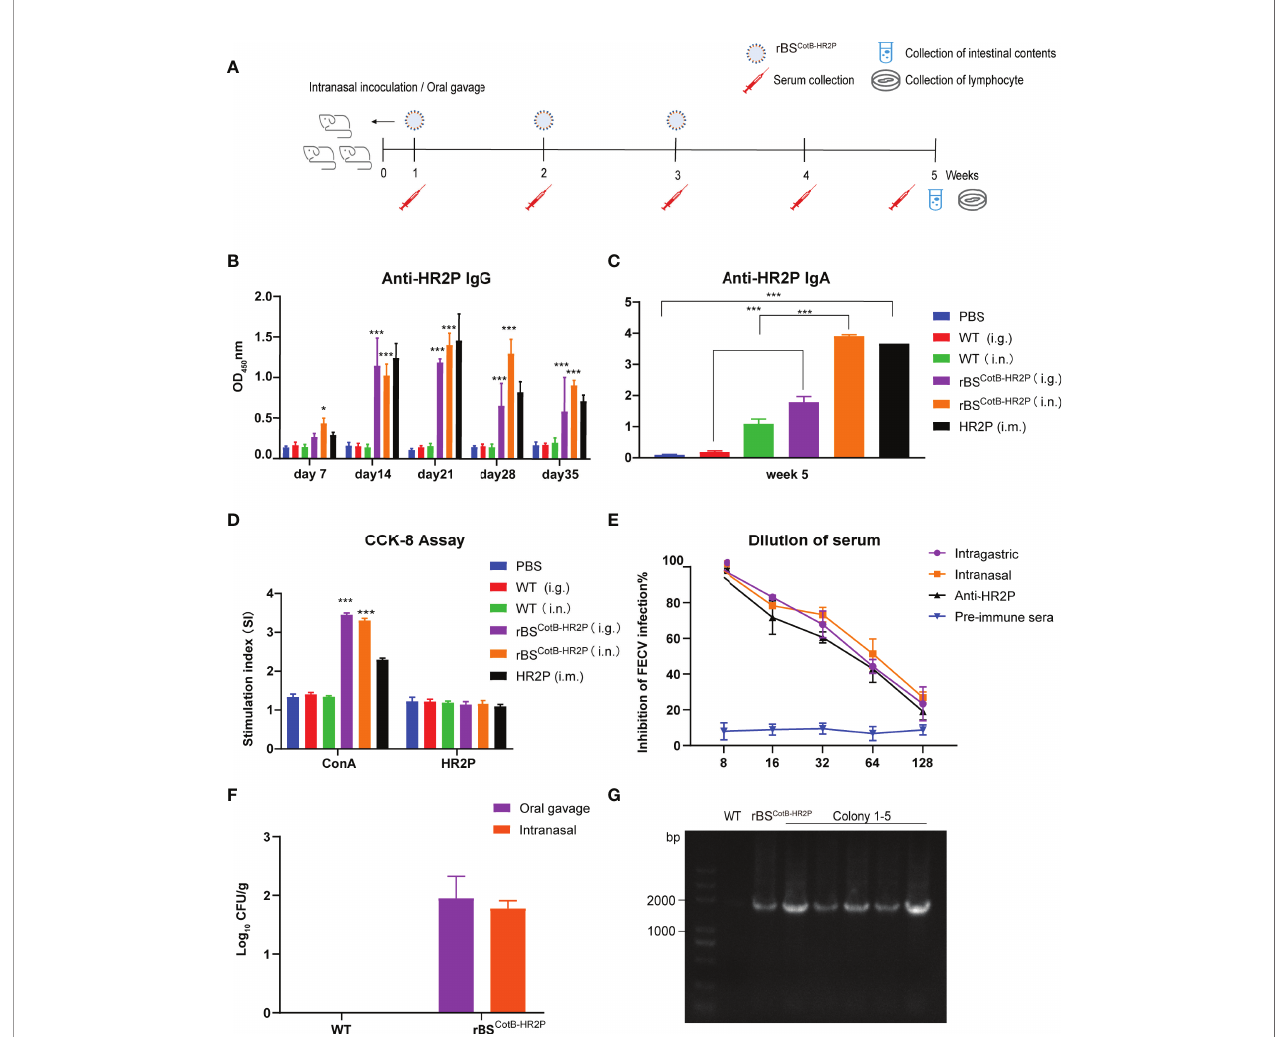
FIGURE 3 | Recombinant (B) subtilis spores expressing the CotB-HR2P fusion protein induce speci fi c humoral and cellular immune responses in mice. (A) Scheme of mouse experiment in which fi ve-week-old female mice (n = 6 each group) were inoculated with either PBS (Ctrl), puri fi ed 50 m g HR2P-His peptide intramuscularly (IM), or 10 8 CFU of the following: wildtype B. subtilis spores intragastric (WT i.g.); WT intranasal (i.n.); recombinant B. subtilis spores displaying the CotB-HR2P fusion protein (rBS CotB-HR2P ) i.g., or rBS CotB-HR2P i.n. Serum and intestinal content were collected at the indicated time points. (B) Anti-HR2P IgG levels in the sera of mice (n = 6 in each group) were measured weekly by ELISA. (C) Anti-HR2P sIgA levels in the intestinal contents of mice (n = 6 in each group) were measured at 5 weeks post-inoculation. (D) Proliferation of mouse splenic lymphocytes was measured by the CCK-8 assay at week 5. (E) Neutralization of anti-HR2P antibody in serum of mice inoculated with WT or rBS CotB-HR2P . CRFK cells were infected with FECV (100 TCID 50 /well) after preincubation with diluted antiserum, and the reduction in viral titer was quanti fi ed. The fi gure represents mean values from three independent experiments, and the error bars indicate the standard deviation. (F) Colonization of rBS CotB-HR2P in the small intestine of mice fi ve weeks after inoculation. (G) PCR analysis of bacterial colony cultured from small intestinal contents using CotB-F and HR2P-R primers. * P <.05; *** P <.005. All data are presented as means ± the SEM. Three technical replicates from a single experiment were